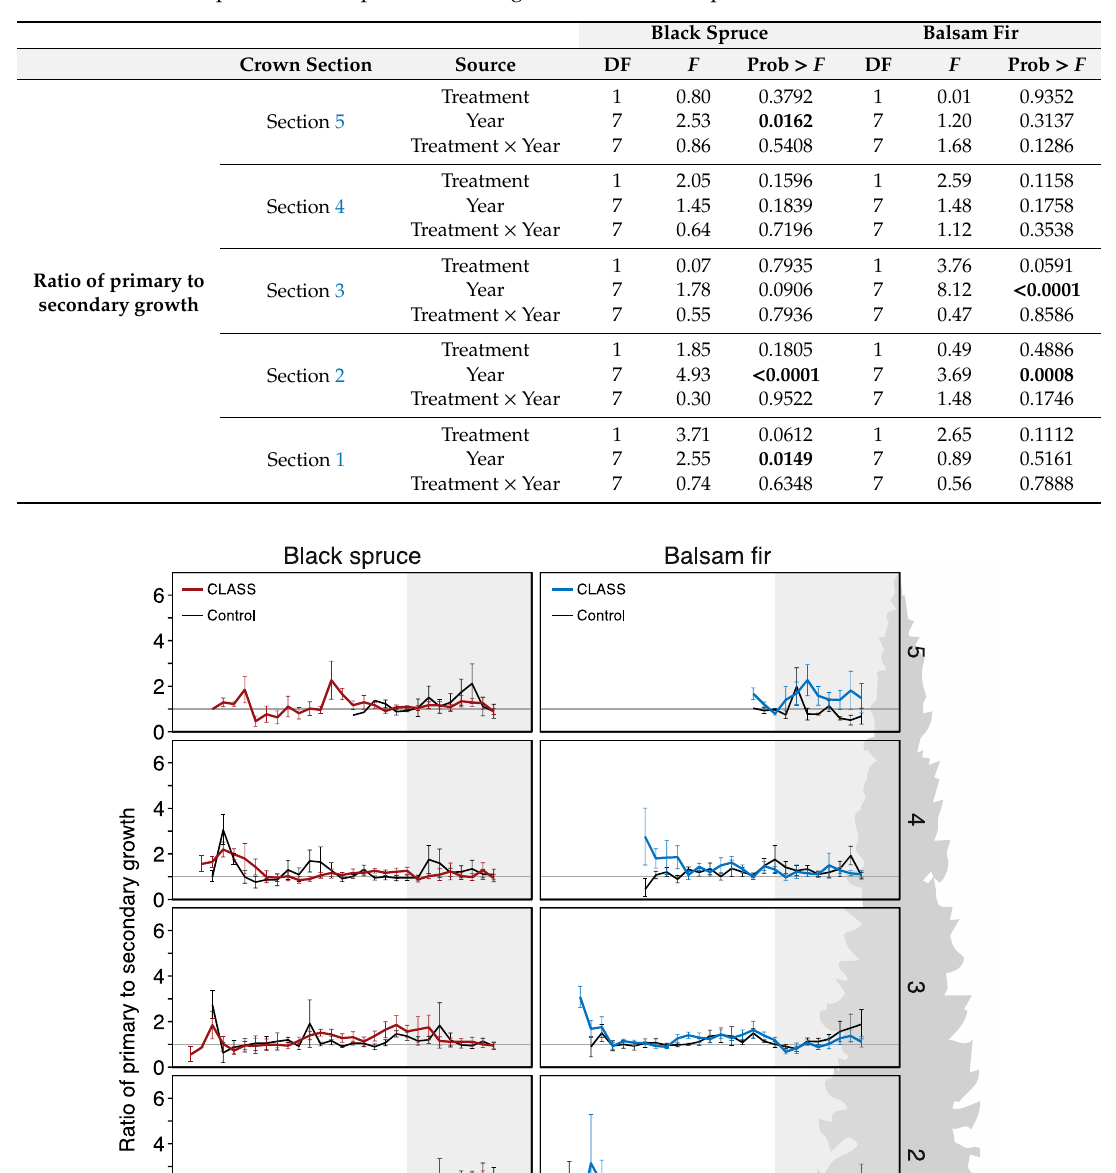
Table 4. Results from mixed model of the ratio of primary to secondary growth along the live crown for black spruce and balsam fir in the years after CLASS. Section 1 represents the base of the crown, and Section 5 represents the top of the tree. Significant results are presented in bold.